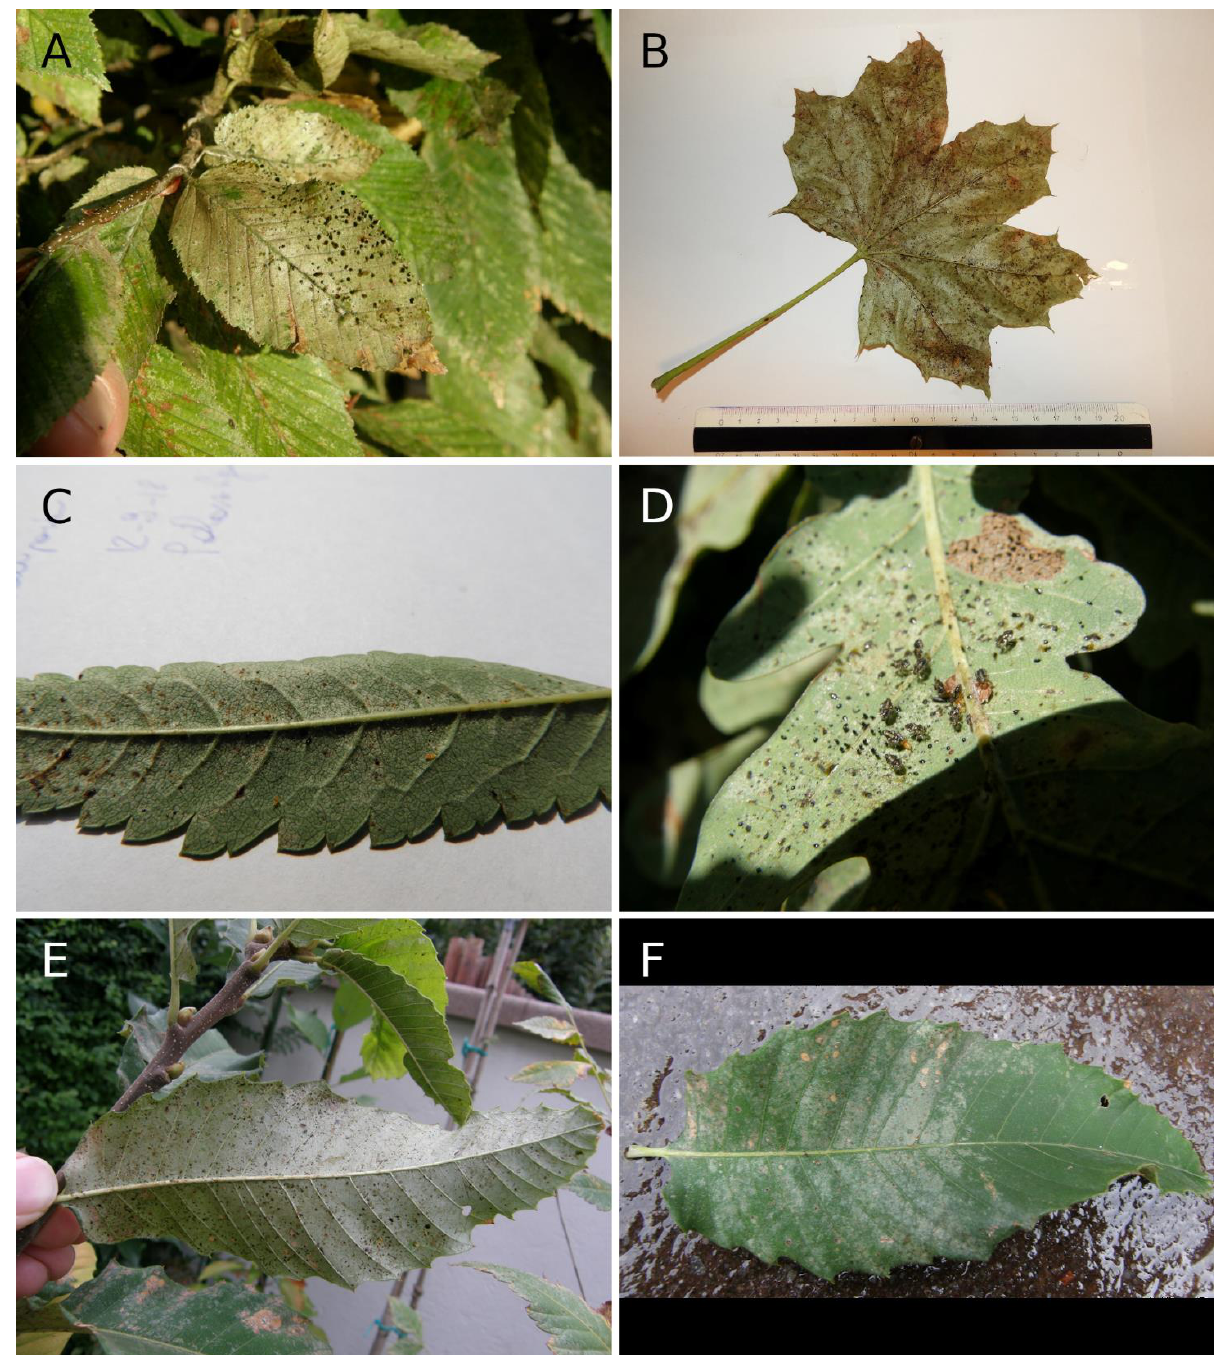
Figure A5. Symptoms of S. rubrocinctus infestation on the lower and upper side of leaves on different host plants: ( A ) Carpinus betulus (Bagnolo Cremasco, 2015); ( B ) Acer platanoides (Palazzo Pignano, 2019); ( C ) Sorbus aucuparia (Palazzo Pignano, 2018); ( D ) Quercus robur (Palazzo Pignano, 2015); ( E , F ) Castanea sativa (Palazzo Pignano, 2015) . Photos A. Wojnar.